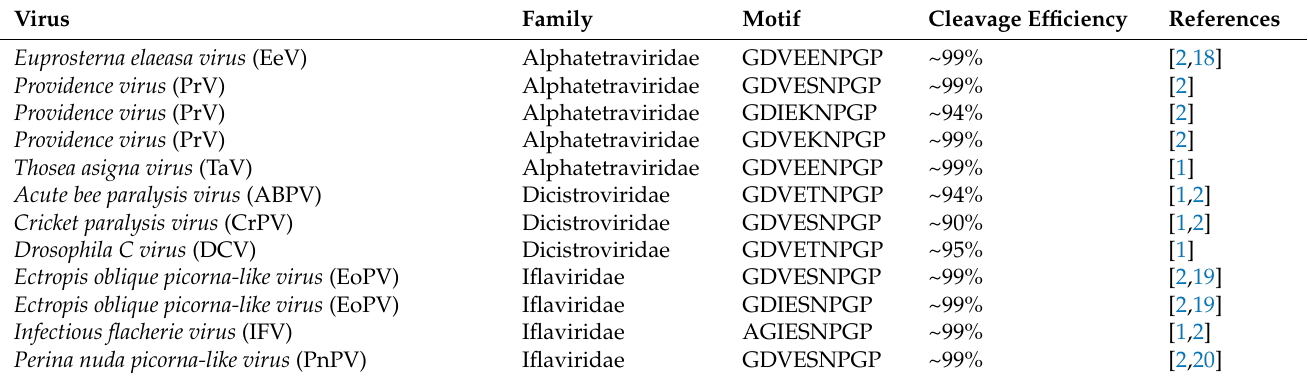
Table 1. Principal 2A/2A-like motifs described in literature and their cleavage